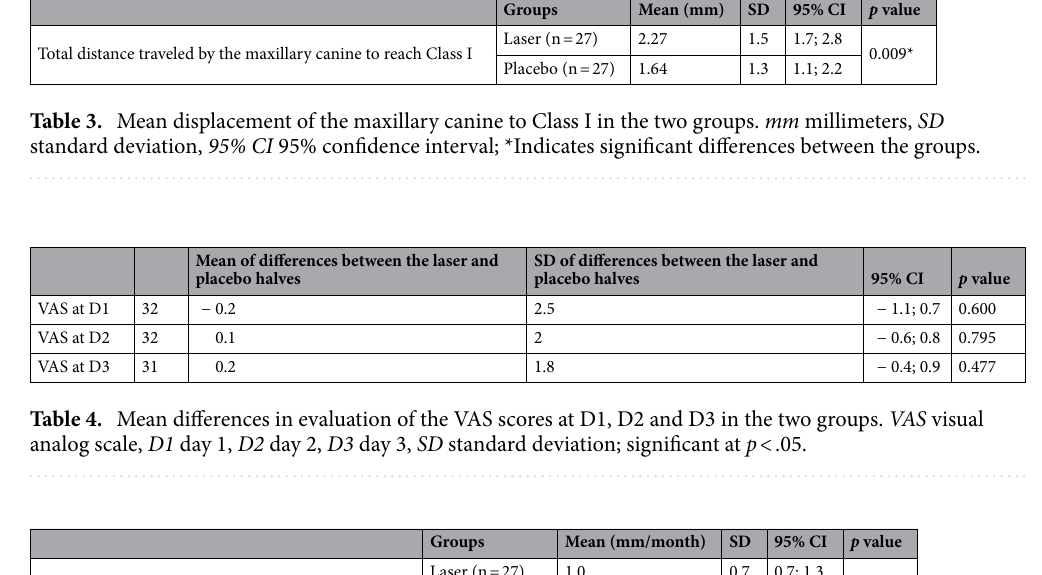
Groups Mean (mm/month) SD 95% CI p value Rate to reach Class I (intention-to-treat